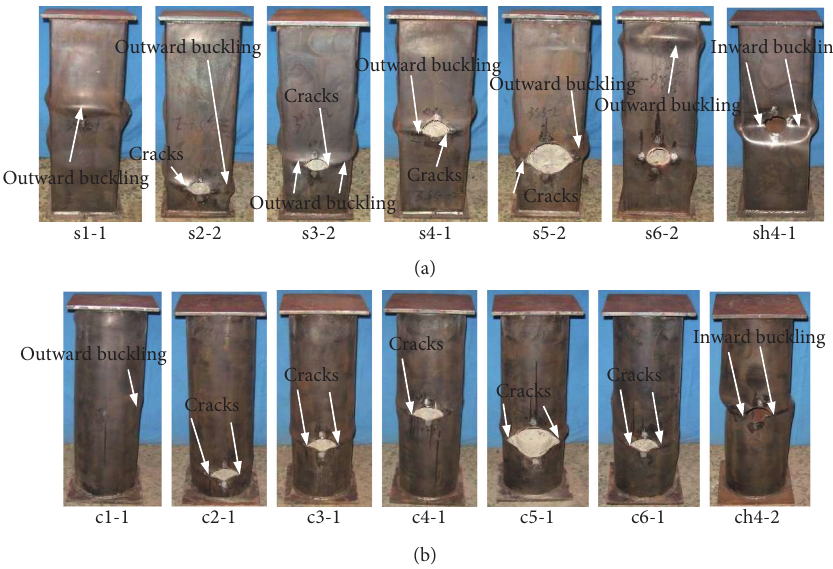
Figure 3: Typical failure modes of opening CFST columns. (a) Square section. (b) Circular section.